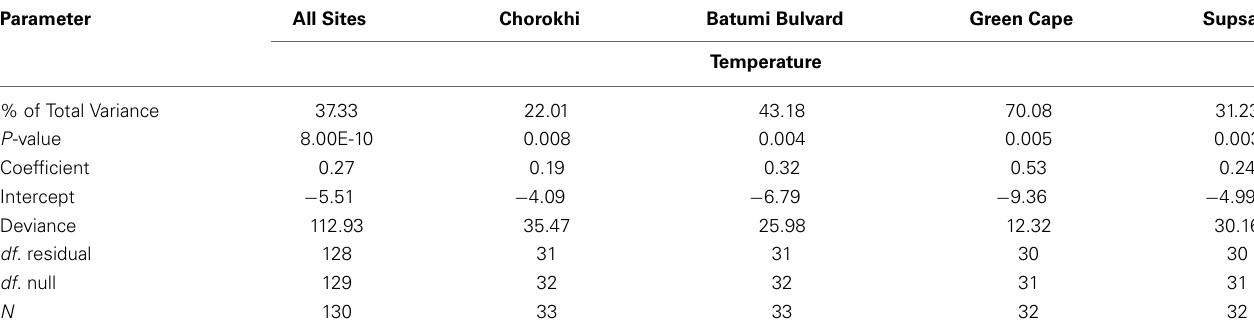
Table 3 | Results of binary logistic regression analysis between V. parahaemolyticus water temperature. Parameter All